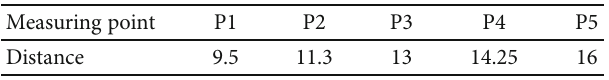
Table 1: Distance of each measuring point from the explosion source in bend pipe